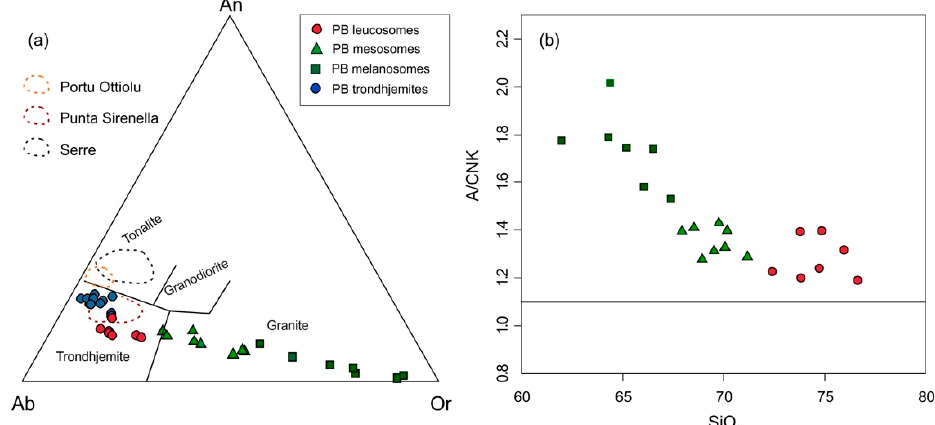
Figure 4. ( a ) Distribution of the Pizzo Bottino (PB) leucosomes, mesosomes and melanosomes in the feldspar CIPW-normative diagram [66]. Trondhjemites from the Pizzo Bottino Pluton (PB trondhjemites; [19]) are also reported in the diagram, as well as the compositions of trondhjemitic leucosomes from late Variscan metasedimentary migmatites from southern Italy (Serre Massif, Calabria, [67]; Punta Sirenella, Sardinia, [68]; Portu Ottiolu, Sardinia, [69]); ( b ) Distribution of studied samples in the A/CNK vs. SiO 2 diagram.